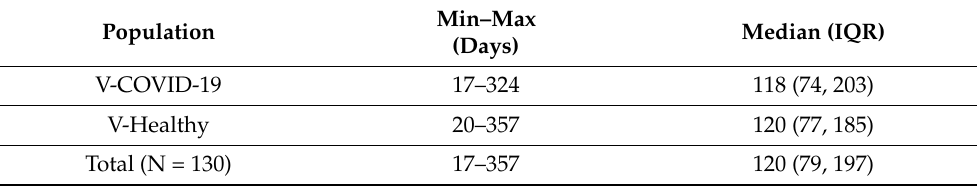
Table 3. Days elapsed between the last vaccine dose and